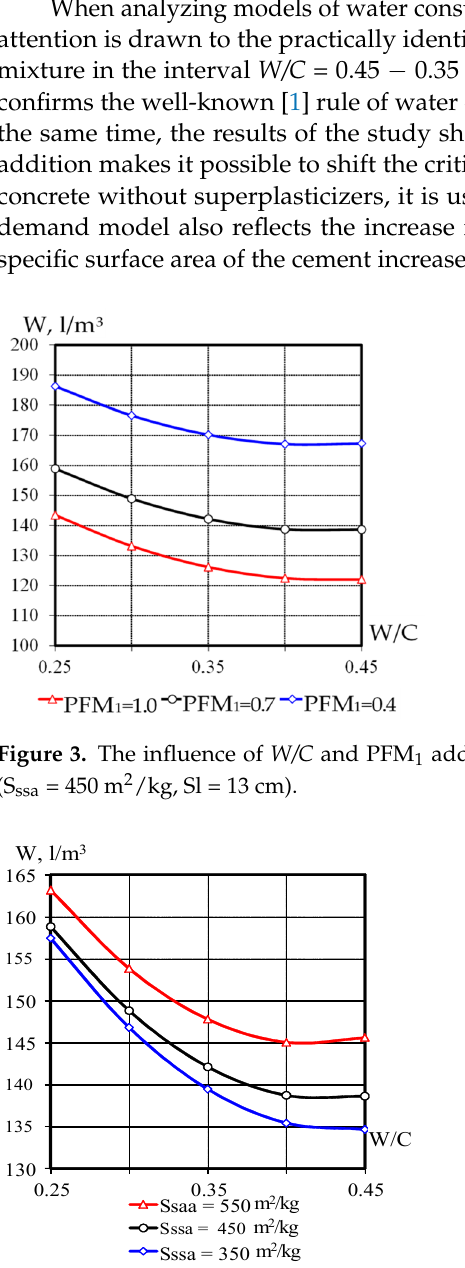
Figure 4. The influence of W/C and the specific surface area of the CC on the concrete mixture water consumption (PFM 1 = 0.7%, Sl = 13 cm).